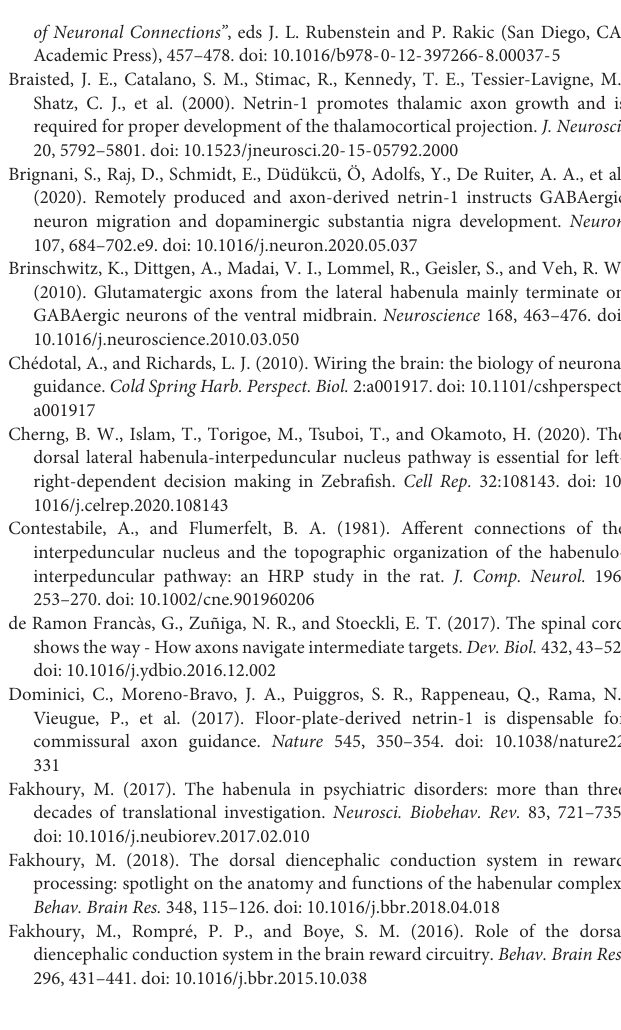
protocol. The arrow indicates the caudal bending of the fr trajectory. Abbreviations: Hb, habenula; Lc, locus coeruleus; mHb fr, medial habenula fasciculus retroflexus; ob, olfactory bulb; SNc, substantia nigra pars compacta; VTA, ventral tegmental area. Supplementary Video 2 | Video generated by Imaris of a E16.5 Gli2 − / − brain with fluorescent IHC for TH (white) and Robo3 (magenta) by the iDISCO protocol. The arrow indicates the rostral abnormal bending of the fr trajectory in this mutant. Abbreviations: Hb, habenula; Lc, locus coeruleus; mHb fr, medial habenula fasciculus retroflexus; ob, olfactory